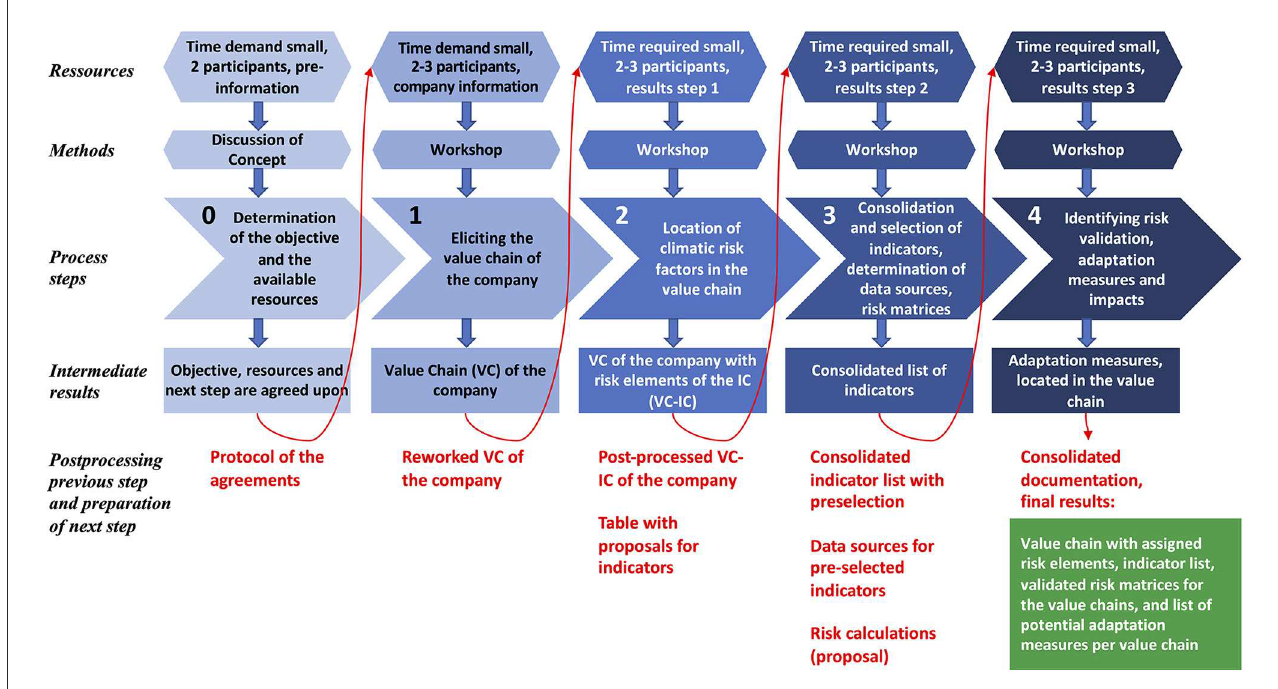
FIGURE4 Procedures for the elicitation of a value chain, for pinpointing risk factors therein, for risk quantification and validation, and for the planning of adaptation measures.